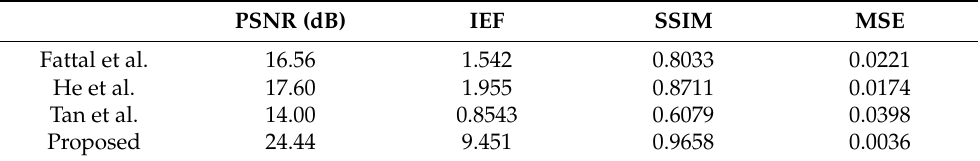
Table 4. Comparison result 1 using upper image from Figure 15.